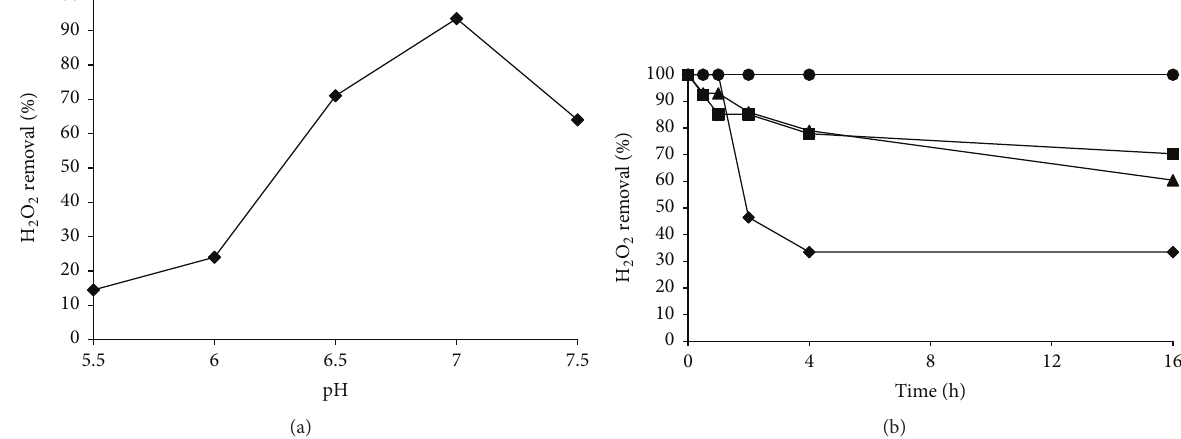
Figure 2: Analysis of the pH optimum and pH stability of Bcp1. H 2 O 2 removal was measured using the ferrothiocyanate method in the presence of DTT as the electron donor at 37 ∘ C. (a) The optimum pH was measured in buffers within the range pH 5.5–7.5. (b) pH stability was determined at 37 ∘ C by incubating Bcp1 in different buffers, pH 5.5 ( X ), pH 6.0 ( ◼ ), pH 6.5 ( 󳵳 ), and pH 7.0 ( e ), for the following times: 30 min, 1h, 2 h, 4 h, and